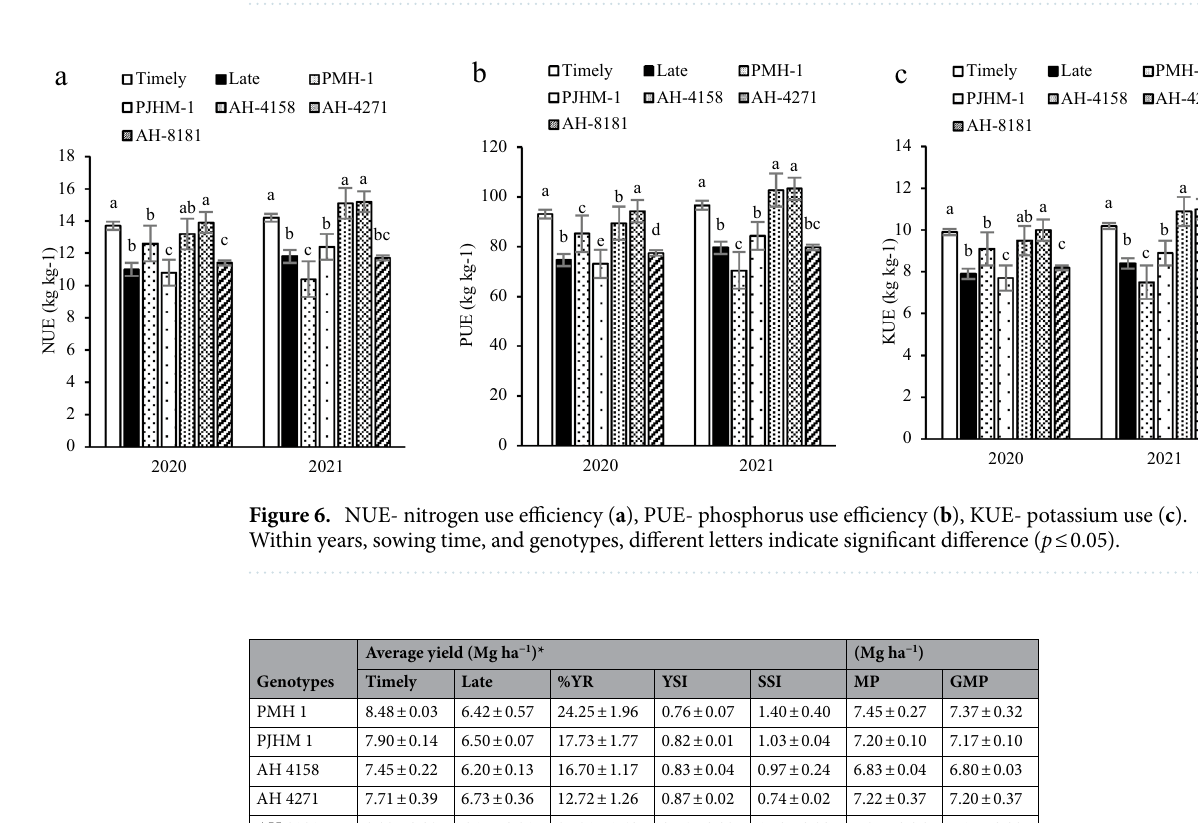
Table 5. Grain stress tolerance indices of maize genotypes under timely and late sown conditions. *Mean yield of 2 years; YR: Percentage yield reduction, YSI: Yield stability index, SSI- Stress susceptibility index, MP: Mean productivity, GMP: Geometric mean productivity.